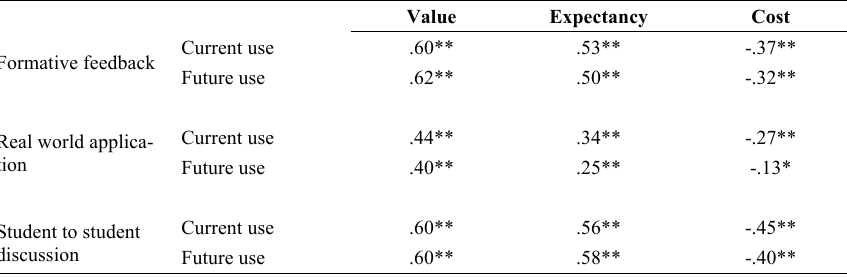
Table 3. Correlations (r-value): Implementation with VECTERS